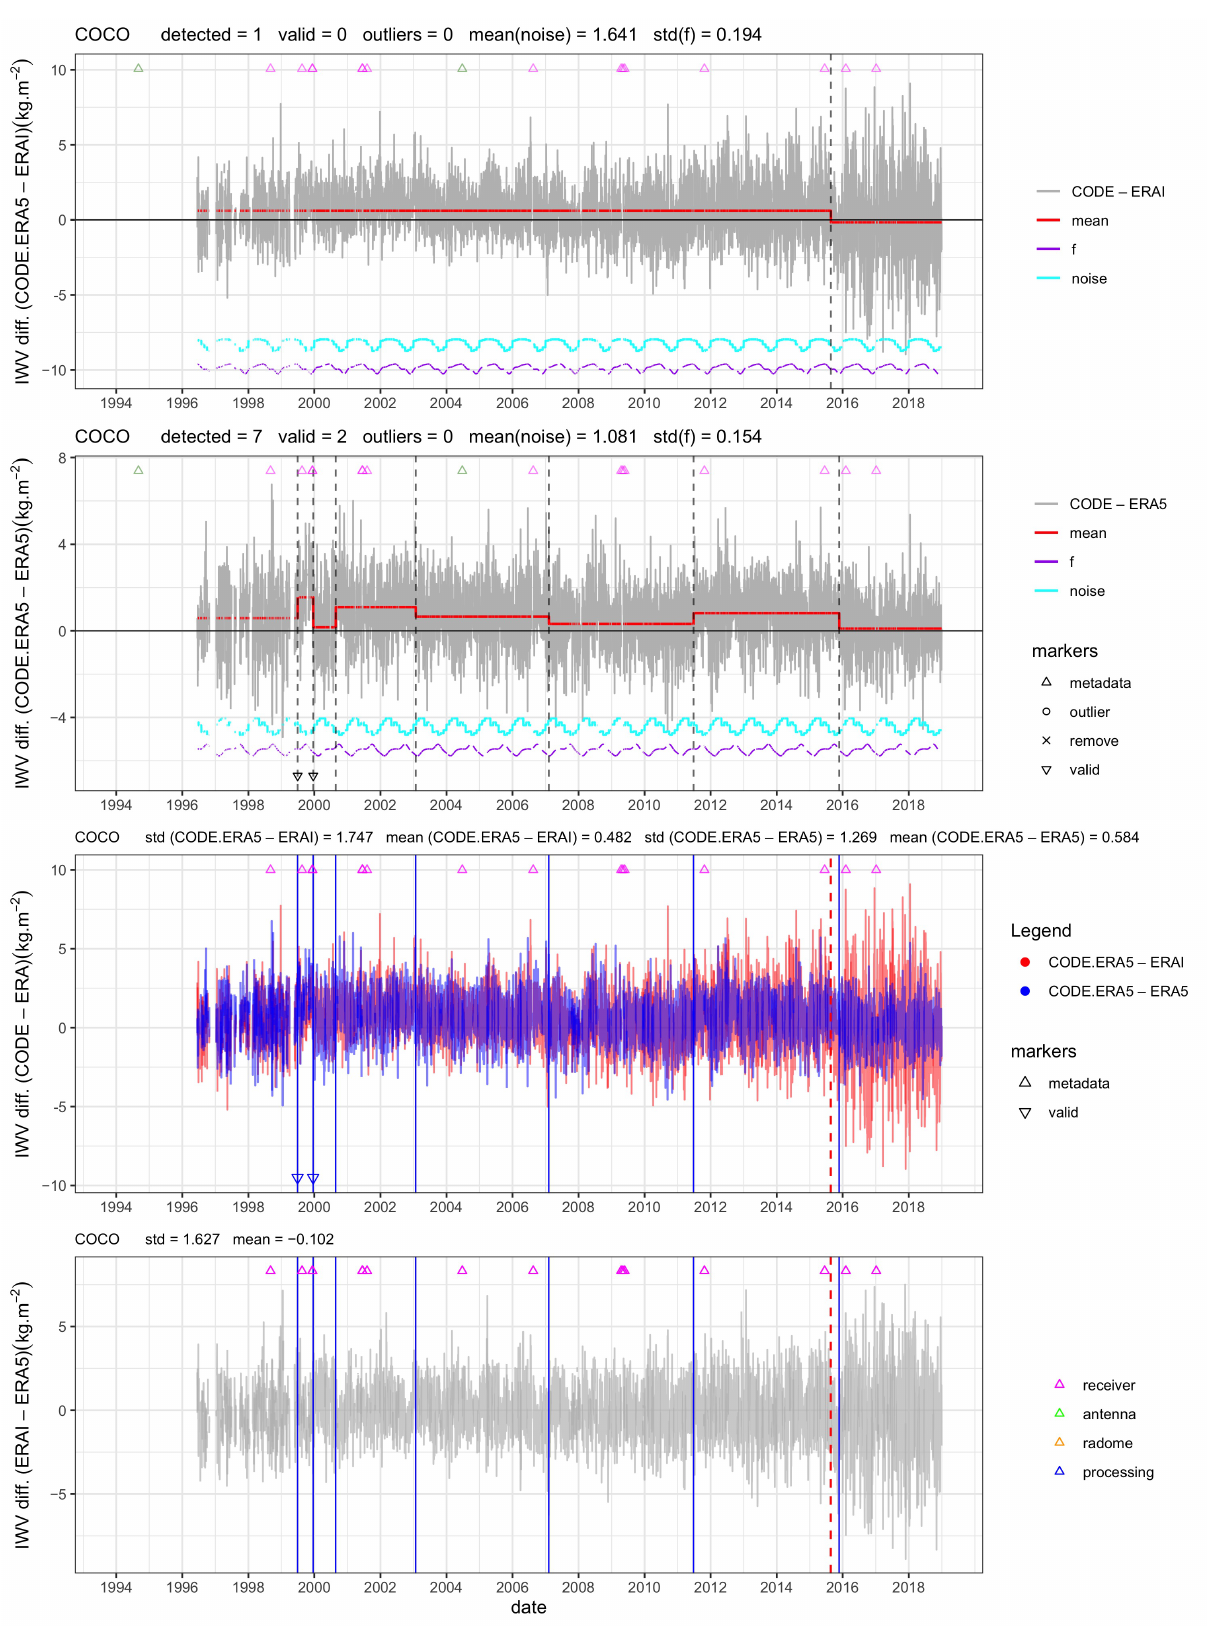
Figure 10. Similar to Figure 4, but for station COCO (Cocos (Keeling) Island,